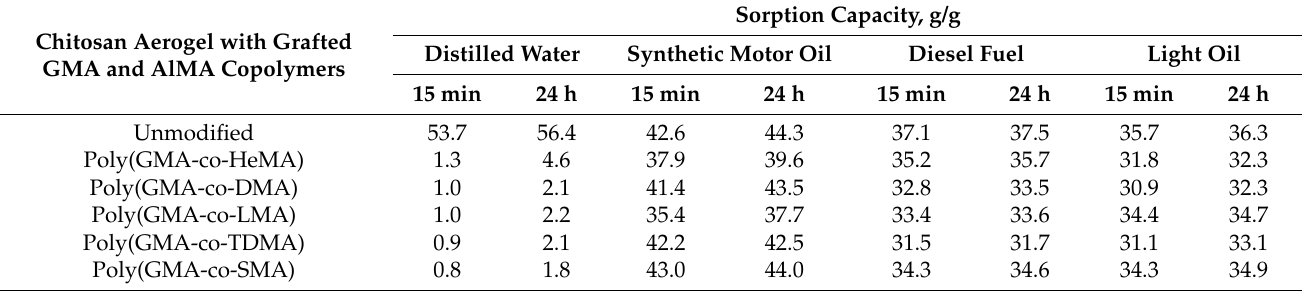
Table 9. Sorption capacity of chitosan aerogels as a result of modification with GMA and AlMA copolymer solutions.